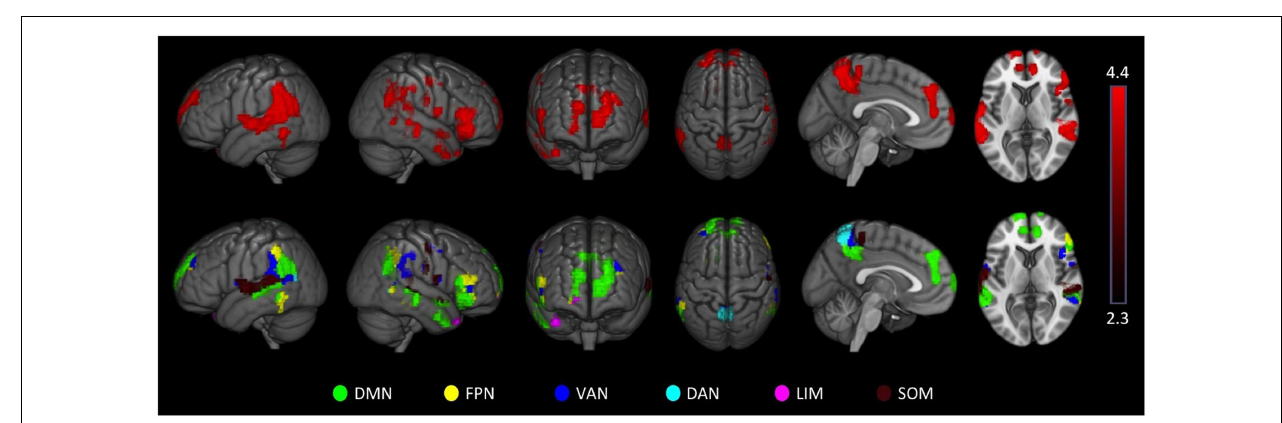
ADHD positive association maps.The lower row shows the same maps color-coded to depict extra-visual networks; SOM = somatomotor; DAN = dorsal attention network;VAN = ventral-attention network; LIM = limbic network; FPN = frontoparietal network; DMN = default mode network. Images are thresholded using a voxelwise threshold of z = 2.3 and a cluster size probability of p < 0.05.